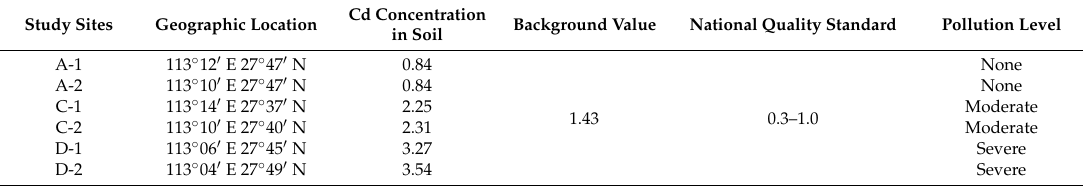
Table 1. Heavy metal Cd concentration of the six study sites.